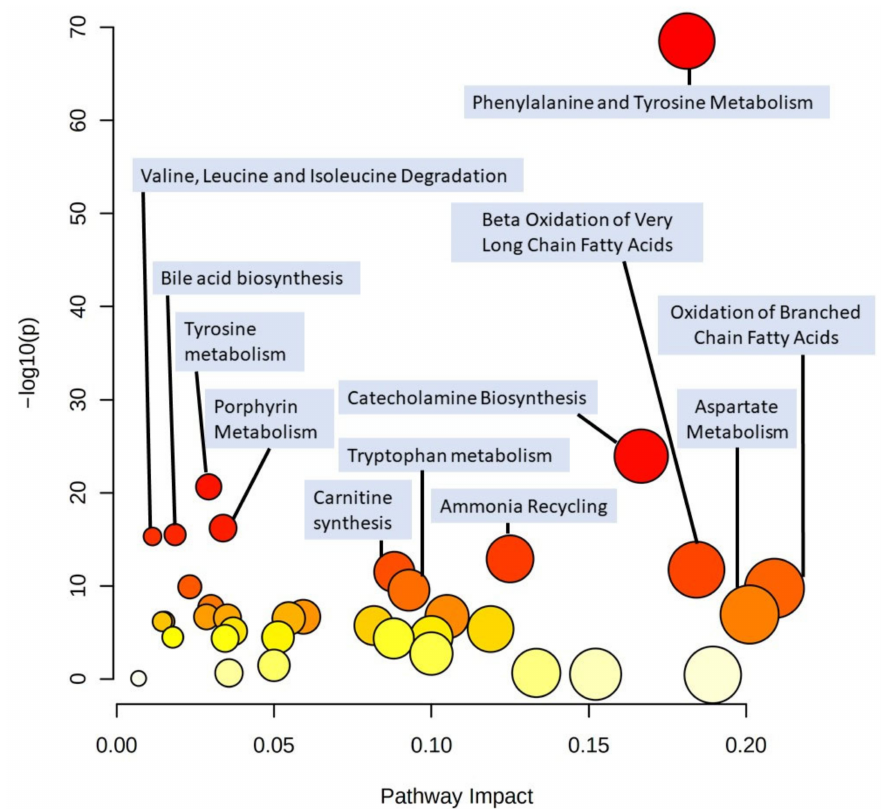
Figure 6. Plot relative to the pathway analysis displaying each altered pathway as a dot, ordered for pathway impact ( x -axis and size) and negative logarithm (base 10) of the p -value ( y -axis and color). The pathway analysis was performed with regressions between metabolites and the BMI of subjects, a GlobalTest was selected as pathway enrichment analysis, an out-degree centrality was chosen as pathway topology analysis, and the SMPDB Homo sapiens library was chosen as pathway